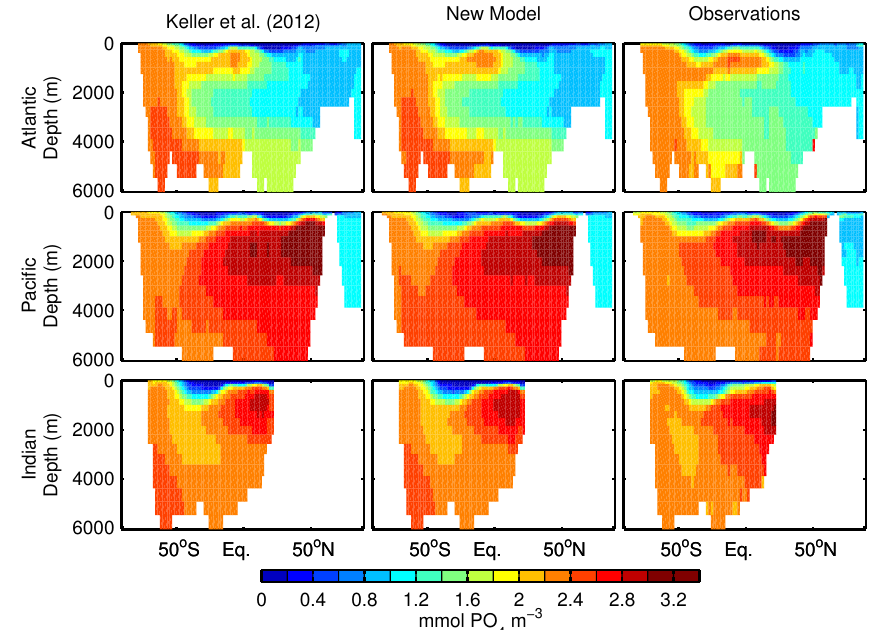
Figure 13. Zonal annual mean phosphate concentrations as simulated with the model by Keller et al. (2012) (left column) and the new model (middle column) in comparison to observations from the World Ocean Atlas 2009 (WOA, 2009) (Garcia et al., 2010b) (right column) for the different ocean basins.